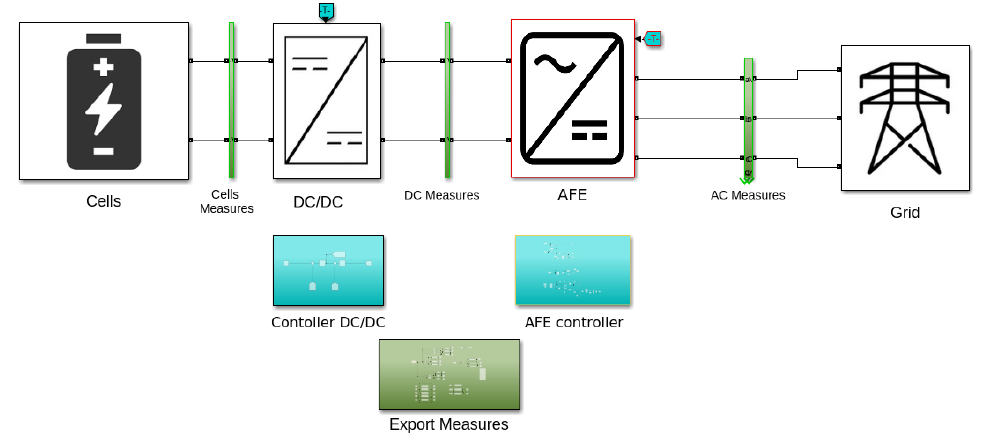
Figure 3. Simulink scheme implementing the used storage